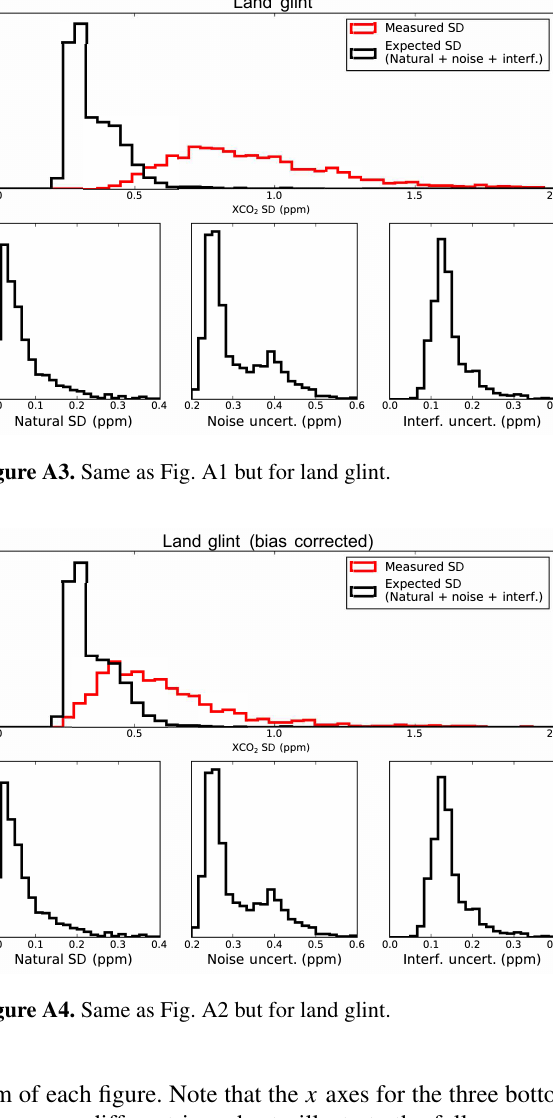
tom of each figure. Note that the x axes for the three bottom figures are different in order to illustrate the full range and shape of the distribution. Figures A1–A6 show that the